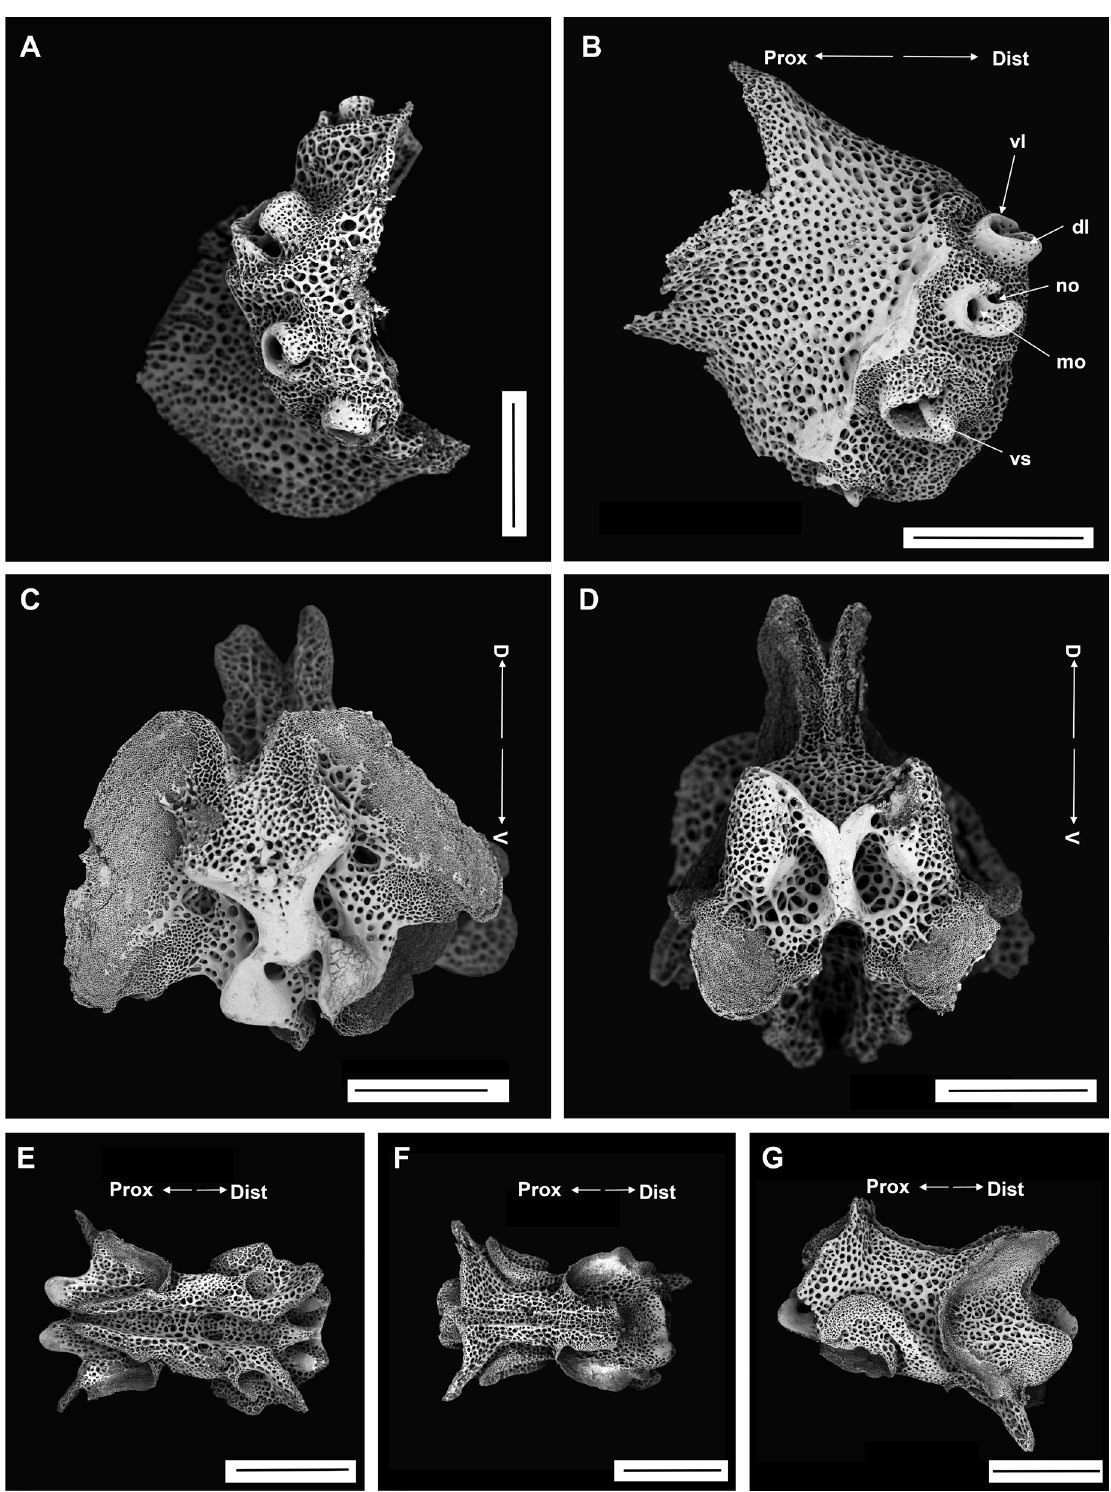
Fig. 26. Ophioplinthaca plicata (Lyman, 1878), SEM (IDSSE EEB-SW0019). A–B . Lateral arm plate. C–G . Vertebrae. C . Proximal view. D . Distal view. E . Ventral view. F . Dorsal view. G . Lateral view. Abbreviations: D = dorsal; Dist = distal; dl = dorsal lobe; mo = muscle opening; no = nerve opening; Prox = proximal; V = ventral; vl = ventral lobe; vs = volute-shaped. Scale bars: A, C–D = 300 µm; B, E–G = 500